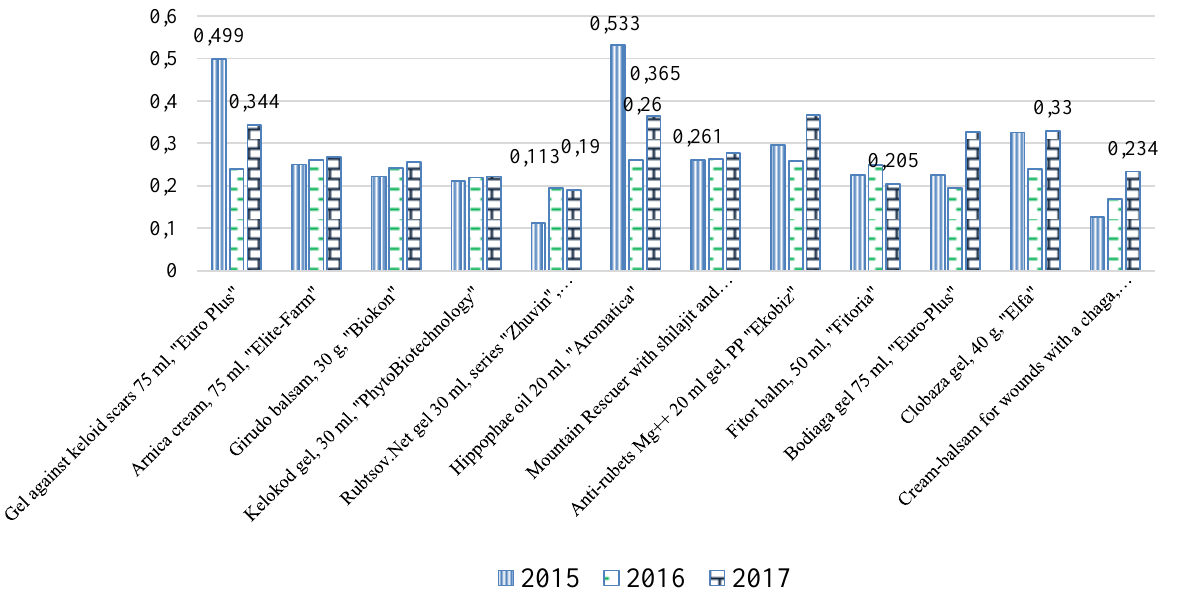
Fig. 3. Dynamics of liquidity ratios for AKPFs in 2015–2017